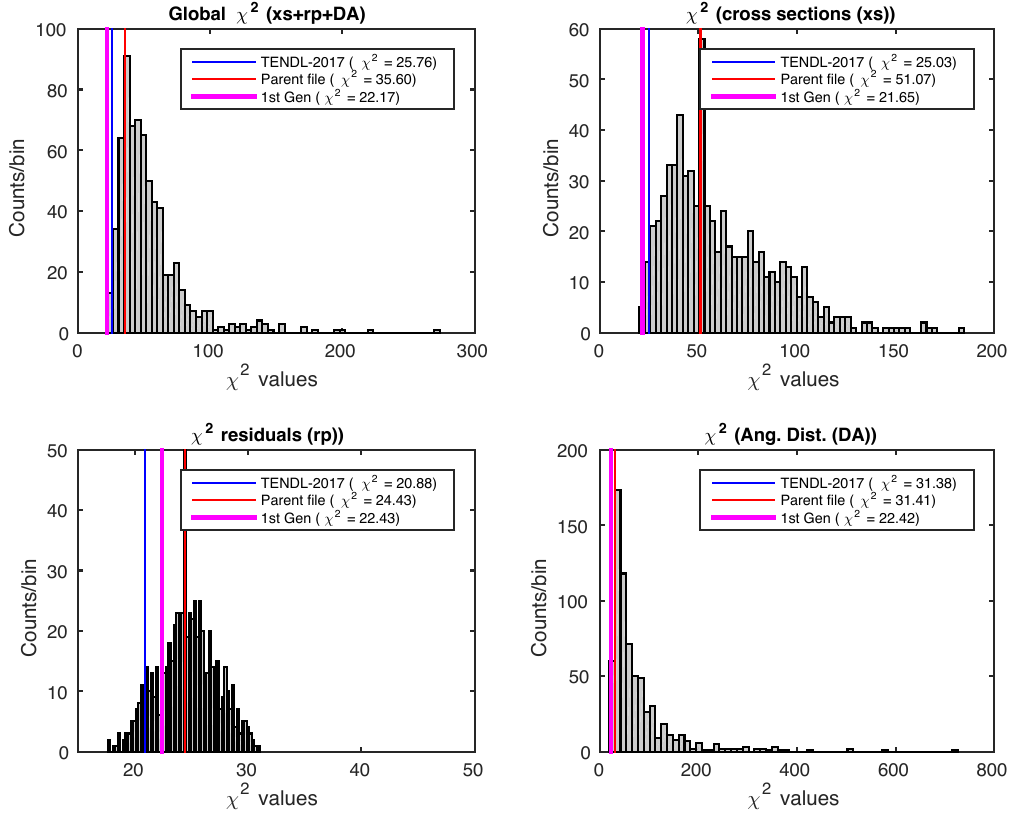
Figure 1. χ 2 distributions for the 1st generation for the three experimental data categories as well as the global χ 2 are presented. xs denotes reaction cross sections, rp – residual production cross sections and DA – angular distributions. A total of 682 random samples were used for each